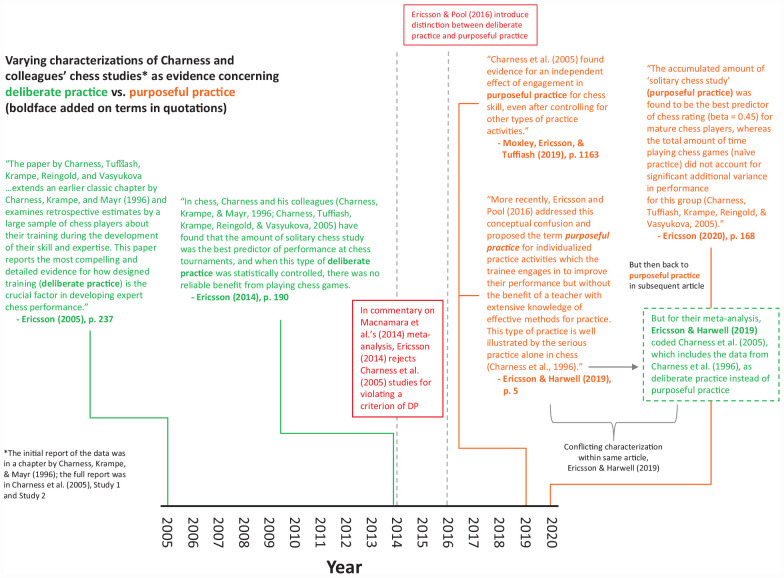
Varying characterizations of Charness et al. (2005) chess studies in Ericsson’s writings.